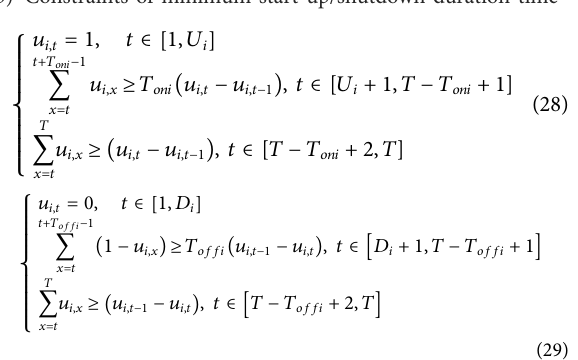
FIGURE 6 Day-ahead and real-time wind